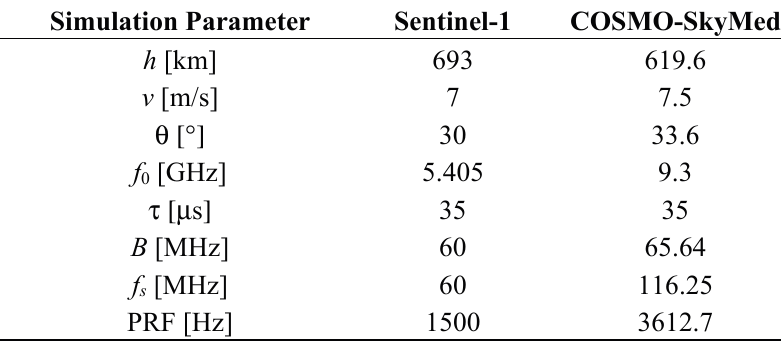
Table 2. Simulation